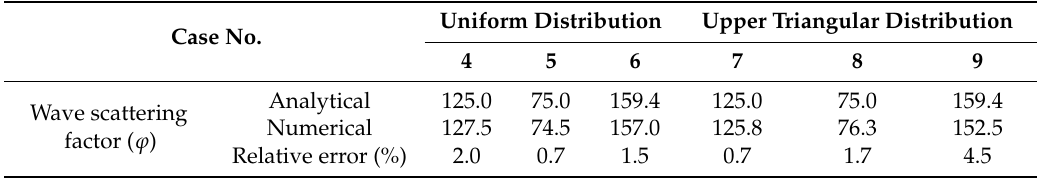
Table 2. Analytical and numerical results of the wave scattering factor.